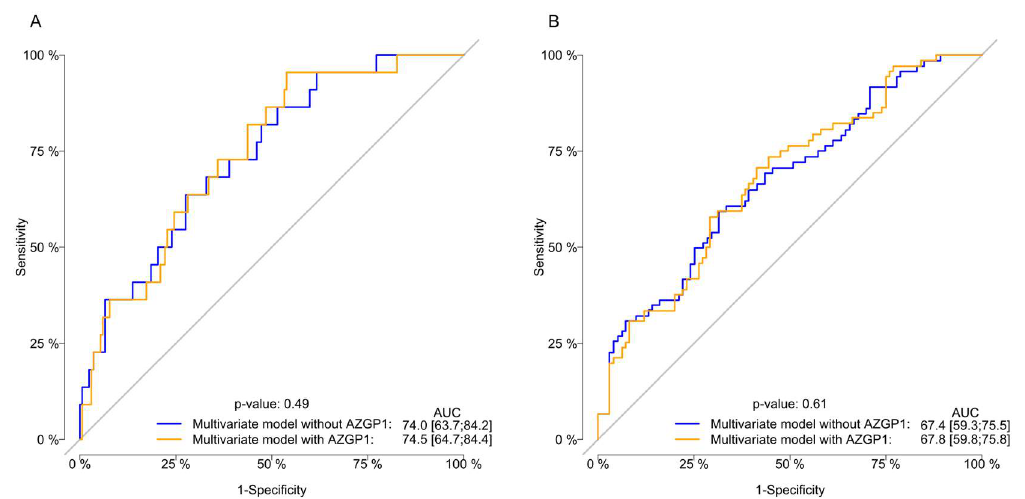
Figure 4. Evaluation of the the model performance for the multivariate cause-specific Cox regression model for the risk of prostate cancer (PCa)-specific death with receiver-operating characteristic (ROC) curves stratified by AZGP1 expression and omitting the AZGP1 status. Area under the ROC curve (AUC) and p -values of the comparative tests are reported one ( A ) and five ( B ) years after the start of ADT.